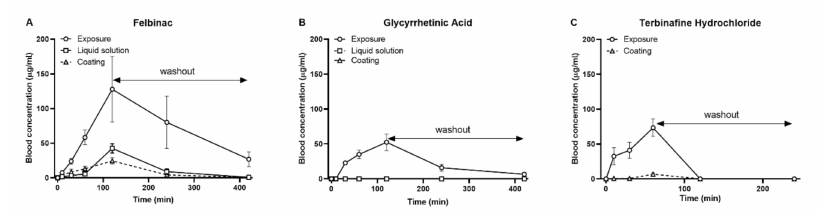
Figure 2. Mean blood concentration-time profiles of felbinac ( A ), glycyrrhetinic acid (GA) ( B ), and terbinafine hydrochloride (TH) ( C ) after exposure and transdermal administrations. Each point and vertical bar indicate the mean and SD (standard deviation), respectively. n = 5.